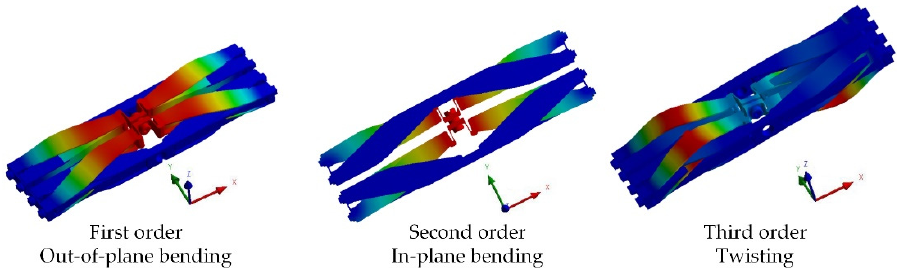
Figure 6. The first three order modal shapes of the